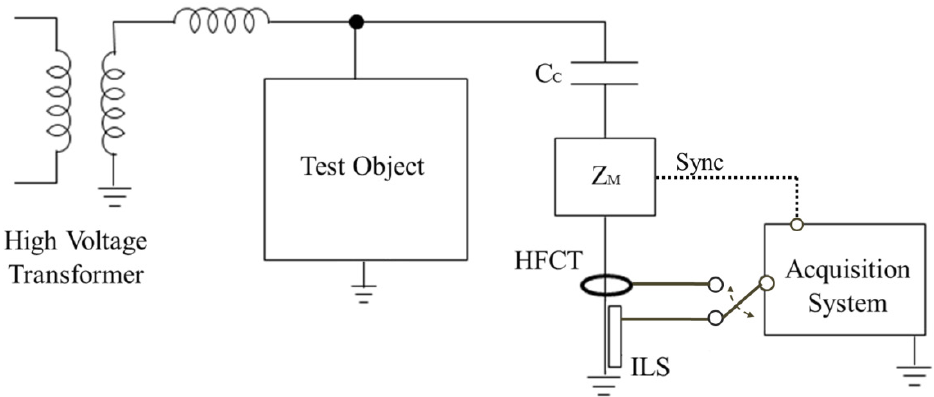
Figure 1. Experimental setup for PD